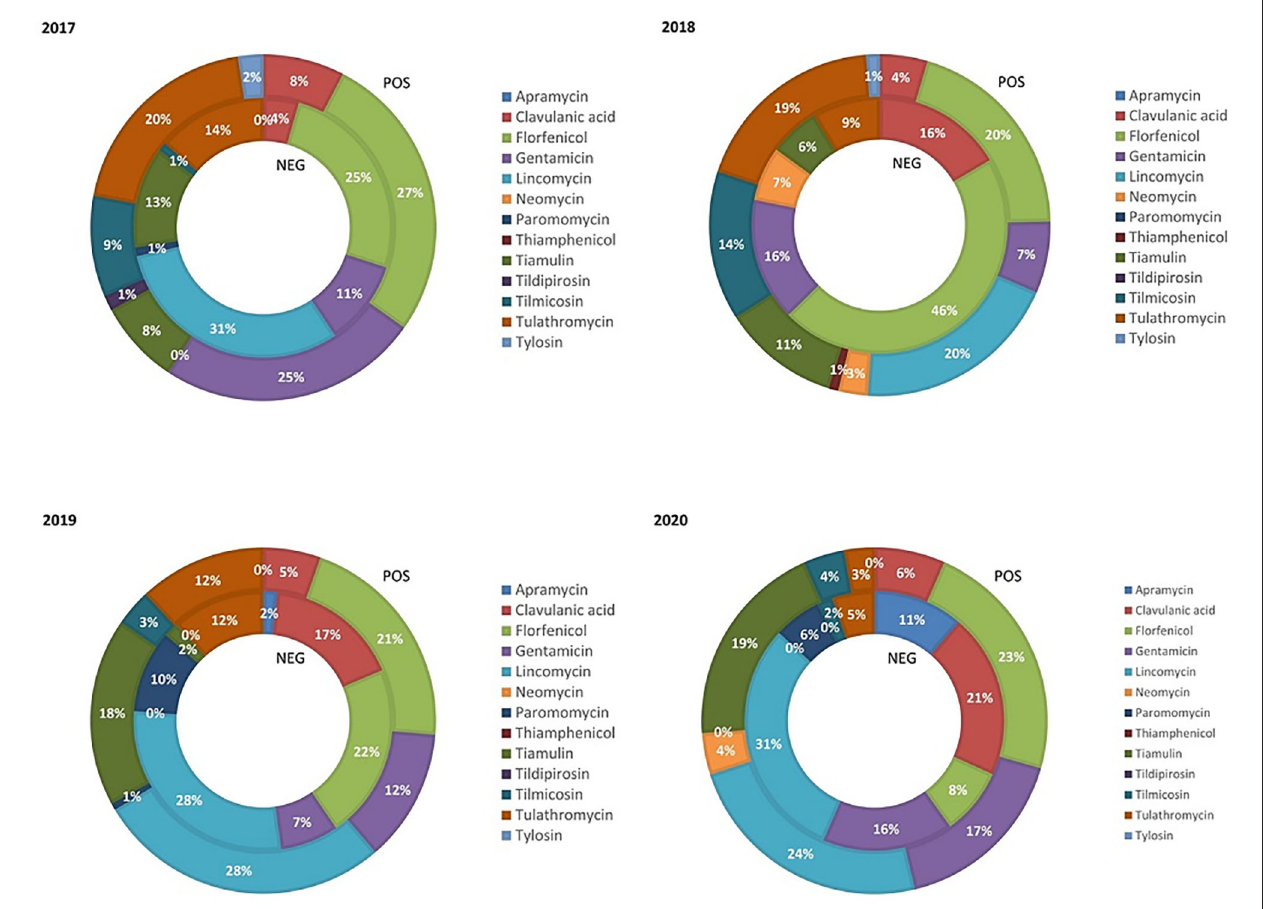
FIGURE 1 | Relative quantity of weaning pig weight treated with class C antibiotics in the PRRS negative (NEG) and PRRS positive (POS) production chains from 2017 to 2020.